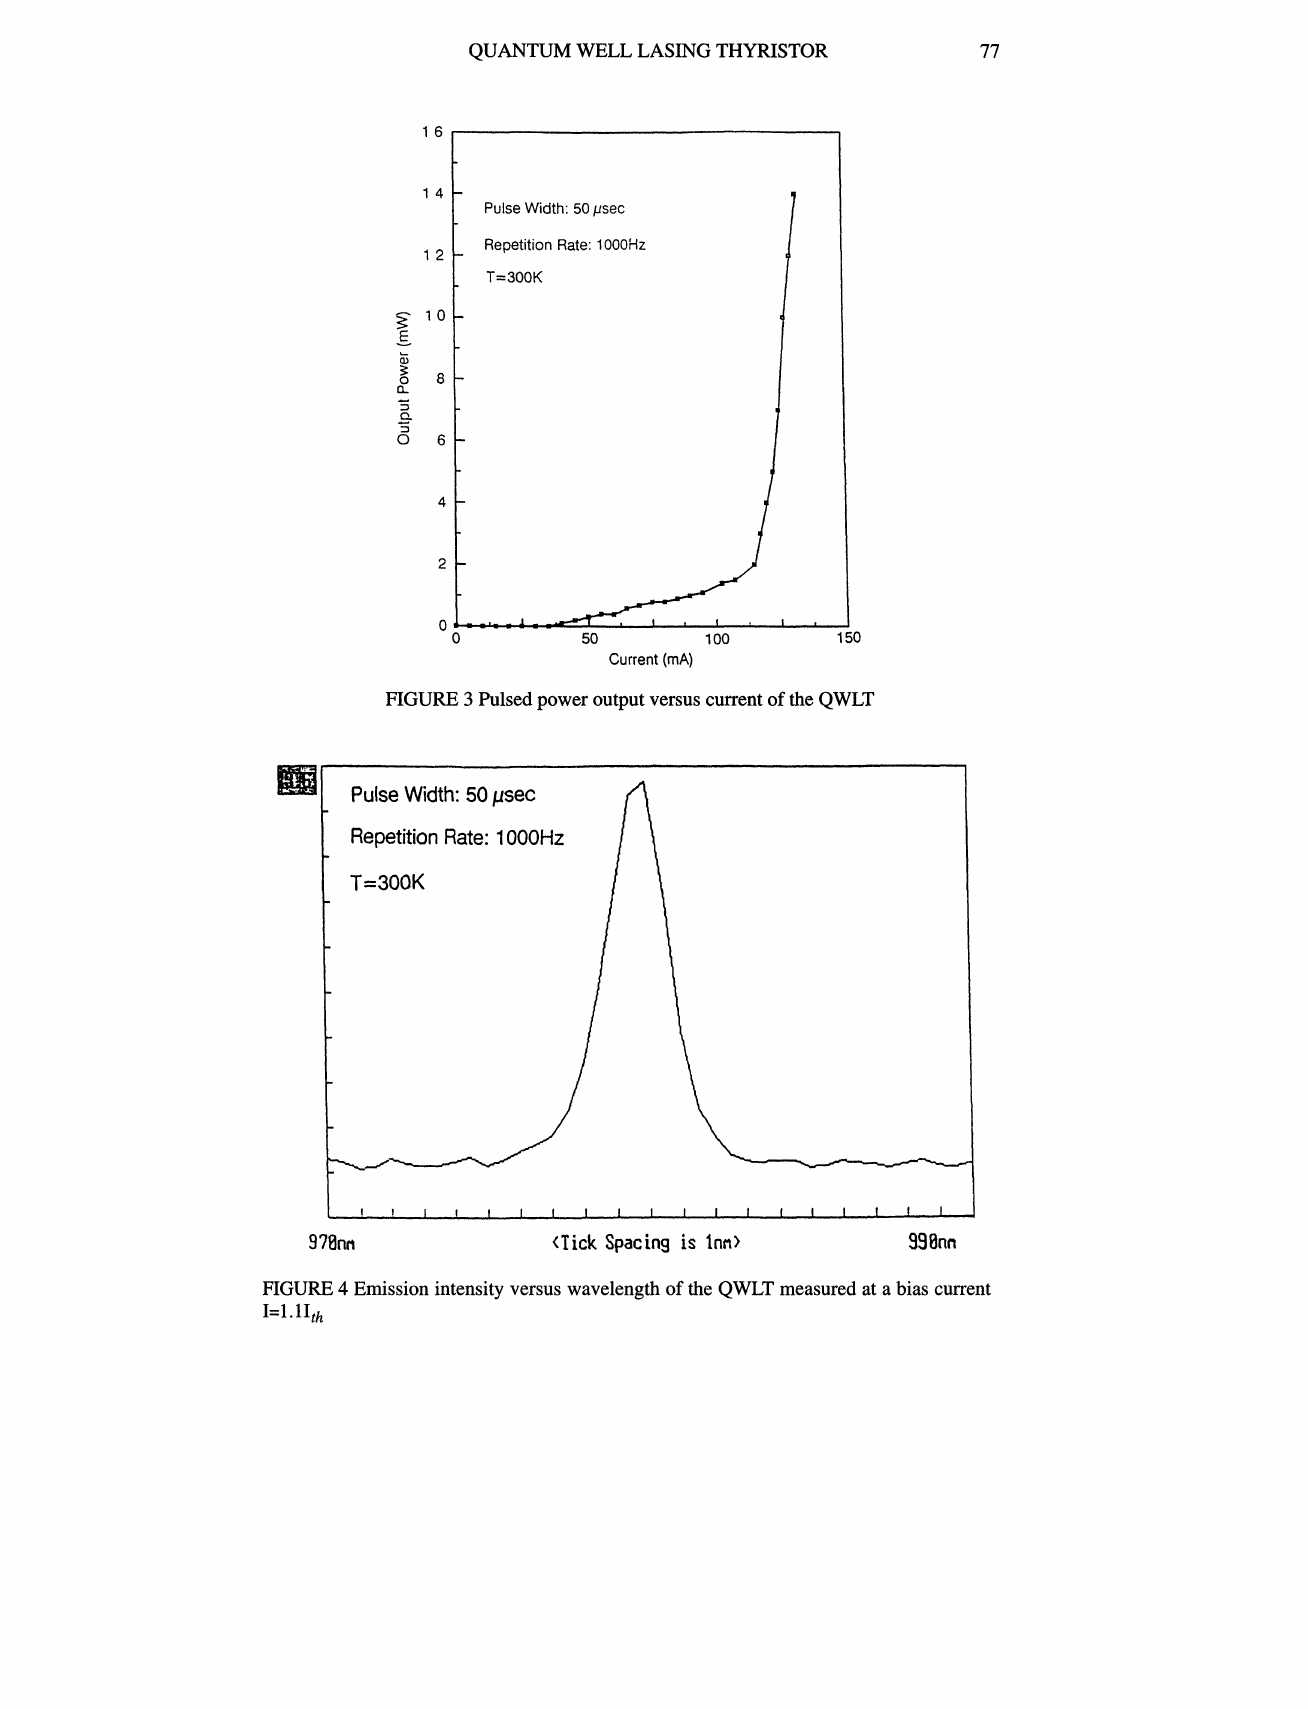
FIGURE 4 Emission intensity versus wavelength of the QWLT measured at a bias current I=1.